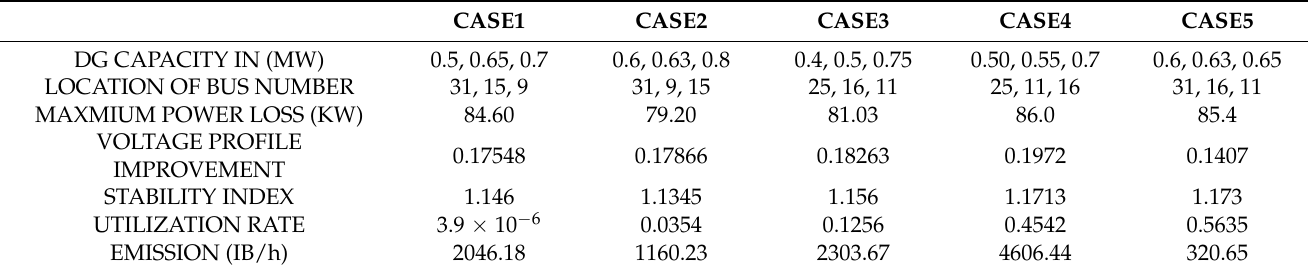
Table 4. Result obtained for the case